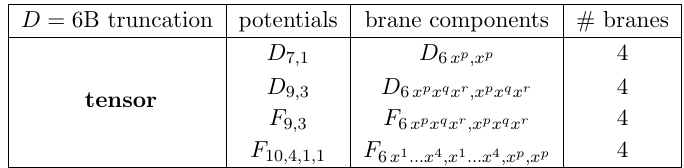
Table 7 . The Z 2 truncation of the maximal theory in D = 6 leading to the N = (2 ; 0) theory. The branes that survive the projection are 16 and in the maximal theory support tensor multiplets in their